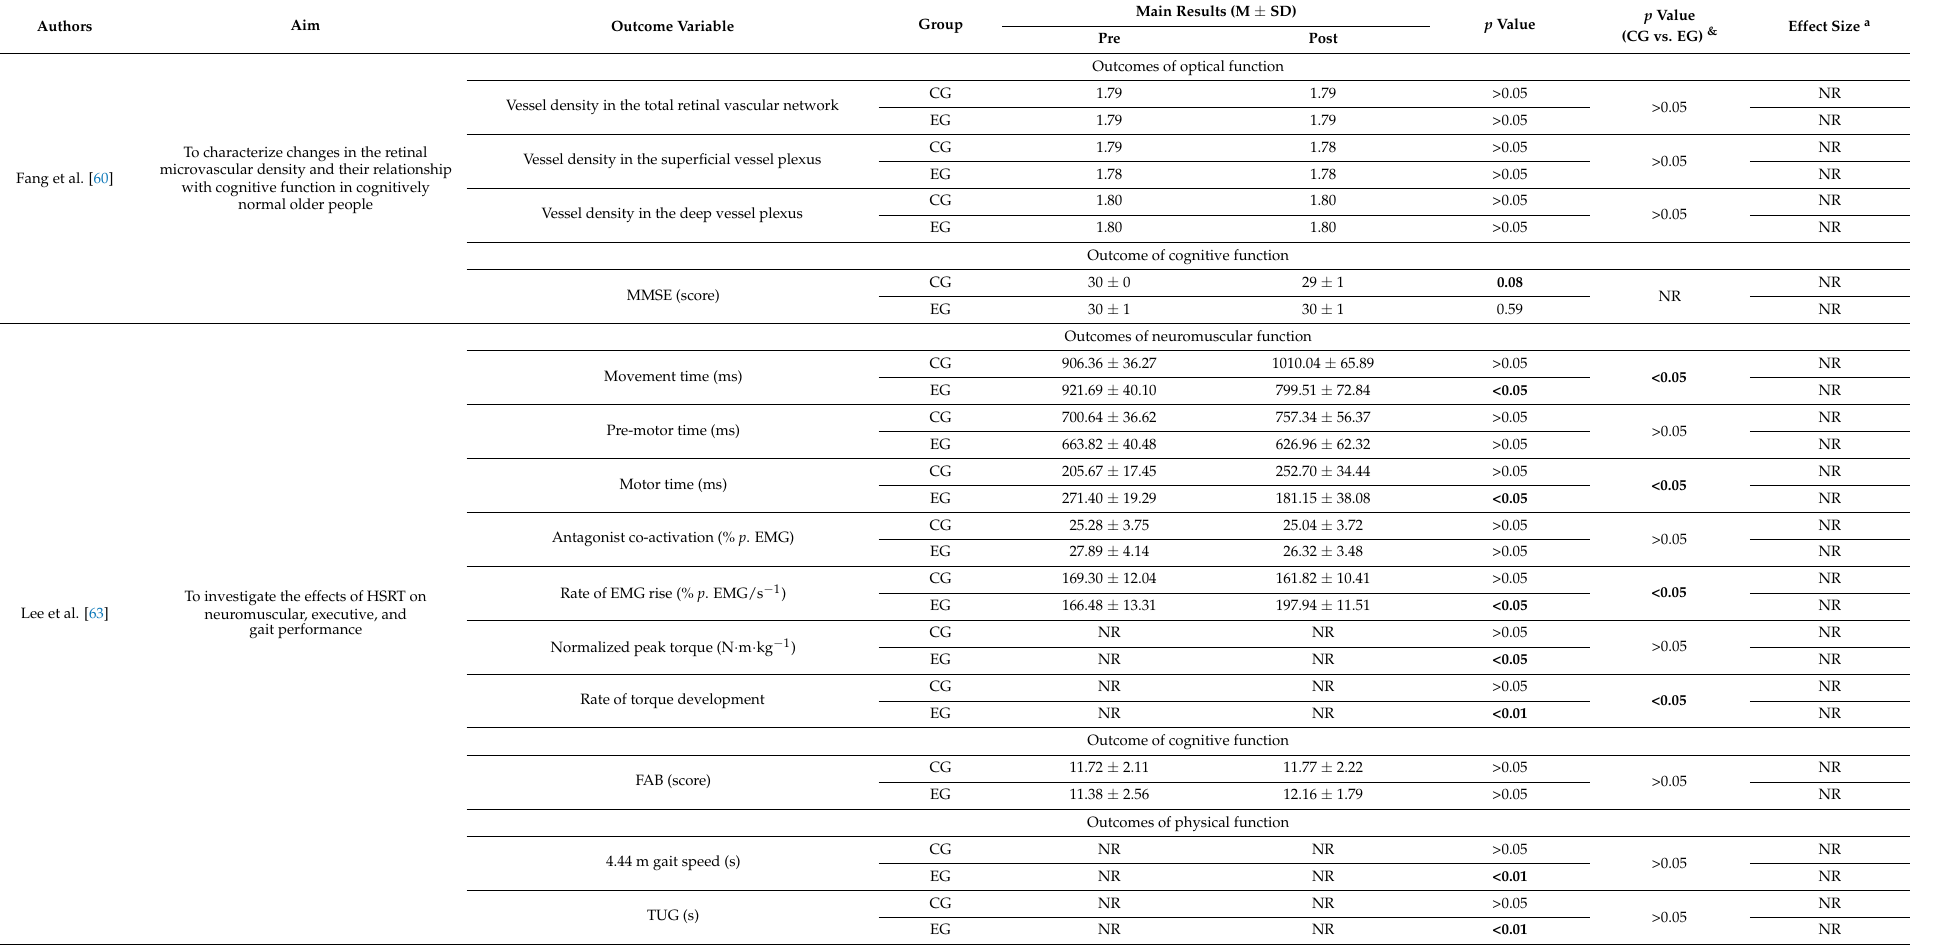
Table 4. Main results of the included